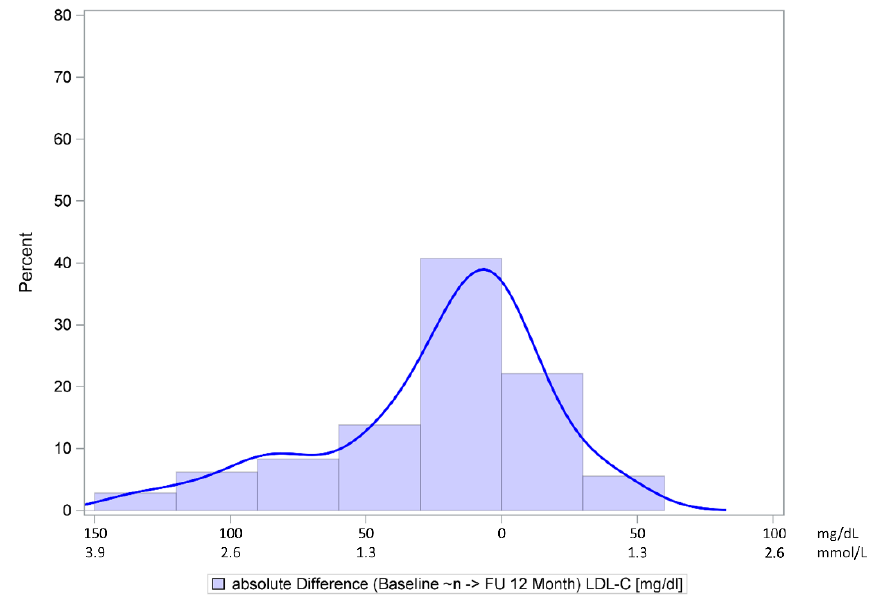
Figure 2. Distribution of LDL-C values (mg/dL) at 12 months (FAS). FAS, full analysis set; FU, follow-up; LDL-C, low-density lipoprotein cholesterol.